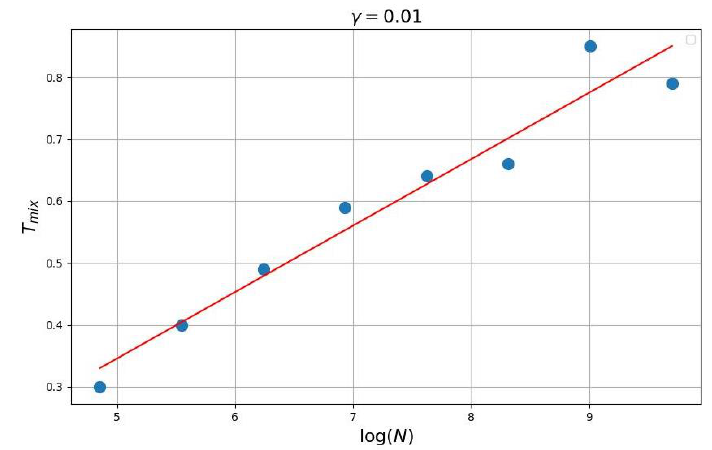
Figure 3. Logit-choice dynamic γ = 0.01.